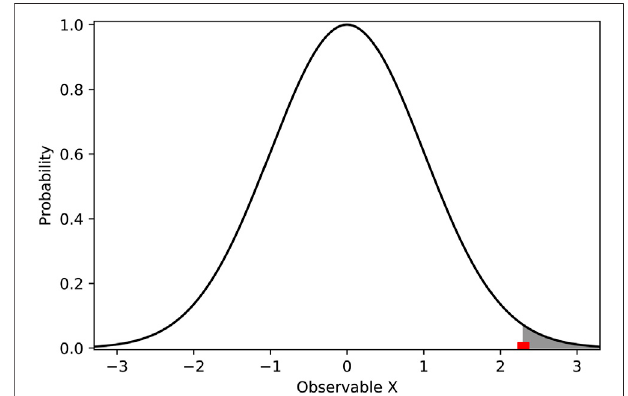
FIGURE 1 | Illustration of the concept of p -value. The fi gure shows the probability distribution of a certain observable X according to the null hypothesis in black. The value of X that is actually observed is shown in red. Although the expected value of X is zero, the observation is not incompatible with the theoretical prediction, given the statistical character of thelater.Theshadedareagivesusthe p -valueoftheobservedvalueof X .Asit is evident from the fi gure, a smaller p -value implies a larger departure from the null